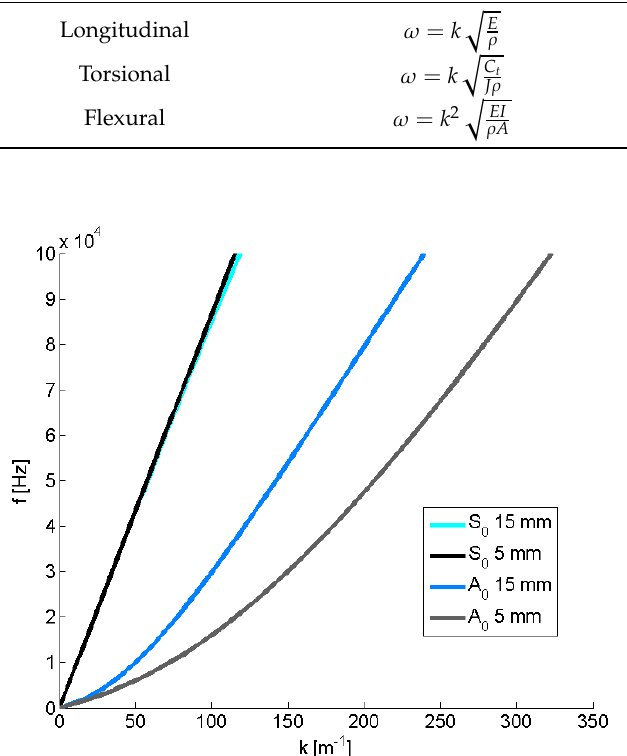
Figure 4. Dispersion curves of the rectangular stem computed from the two plates overlapping as presented [13], one considering a thickness of 15 [mm] and the other one a thickness of 5 [mm]. The axis orientation is presented in Figure 5g. Notice that in this graph the wave number is defined as k = 2 π / λ [m -1 ].